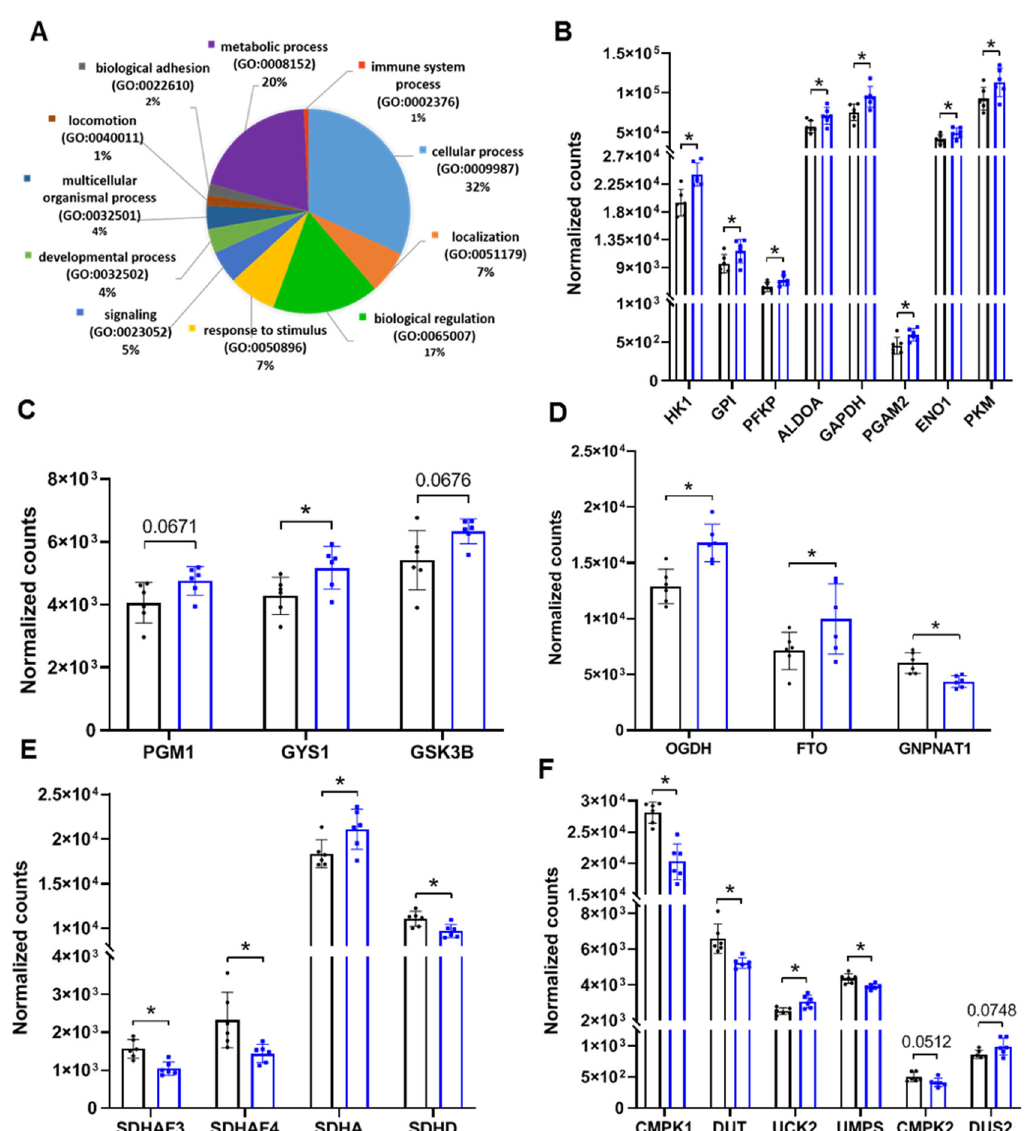
Figure 3. RNA-seq analysis of metabolic markers and pathways in NAECs derived from male children with or without infant RSV infection. ( A ) Biological process analysis of male DEGs from RSV infected vs. RSV uninfected; 20% of DEGs represent changes in biological processes associated with cellular and mitochondrial metabolism (purple portion of the chart). ( B ) Expression of markers of glycolysis. ( C ) Markers of glycosylation and glycogenesis. ( D ) Alpha-ketoglutarate/acetyl-CoA metabolism. ( E ) Succinate metabolism. ( F ) Uridine metabolism. Black bars, healthy controls ( n = 6); blue bars, male samples with RSV infection in infancy (0–12 months) ( n = 6). * p < 0.05 by FDR-corrected test. Trending but not significant p -values are indicated on graphs.